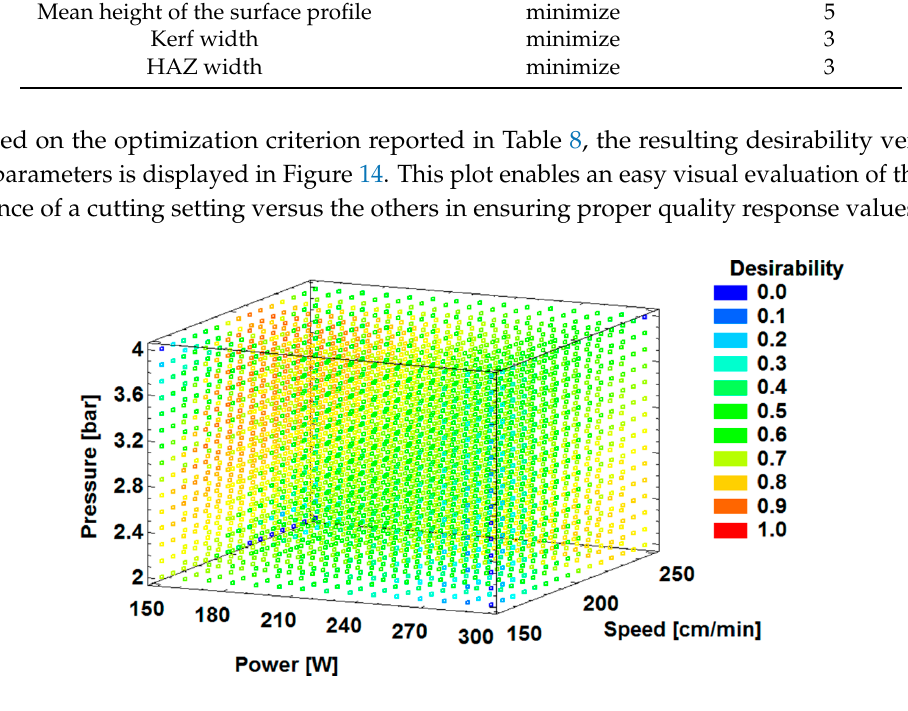
Figure 14. Desirability plot versus laser cutting parameters.